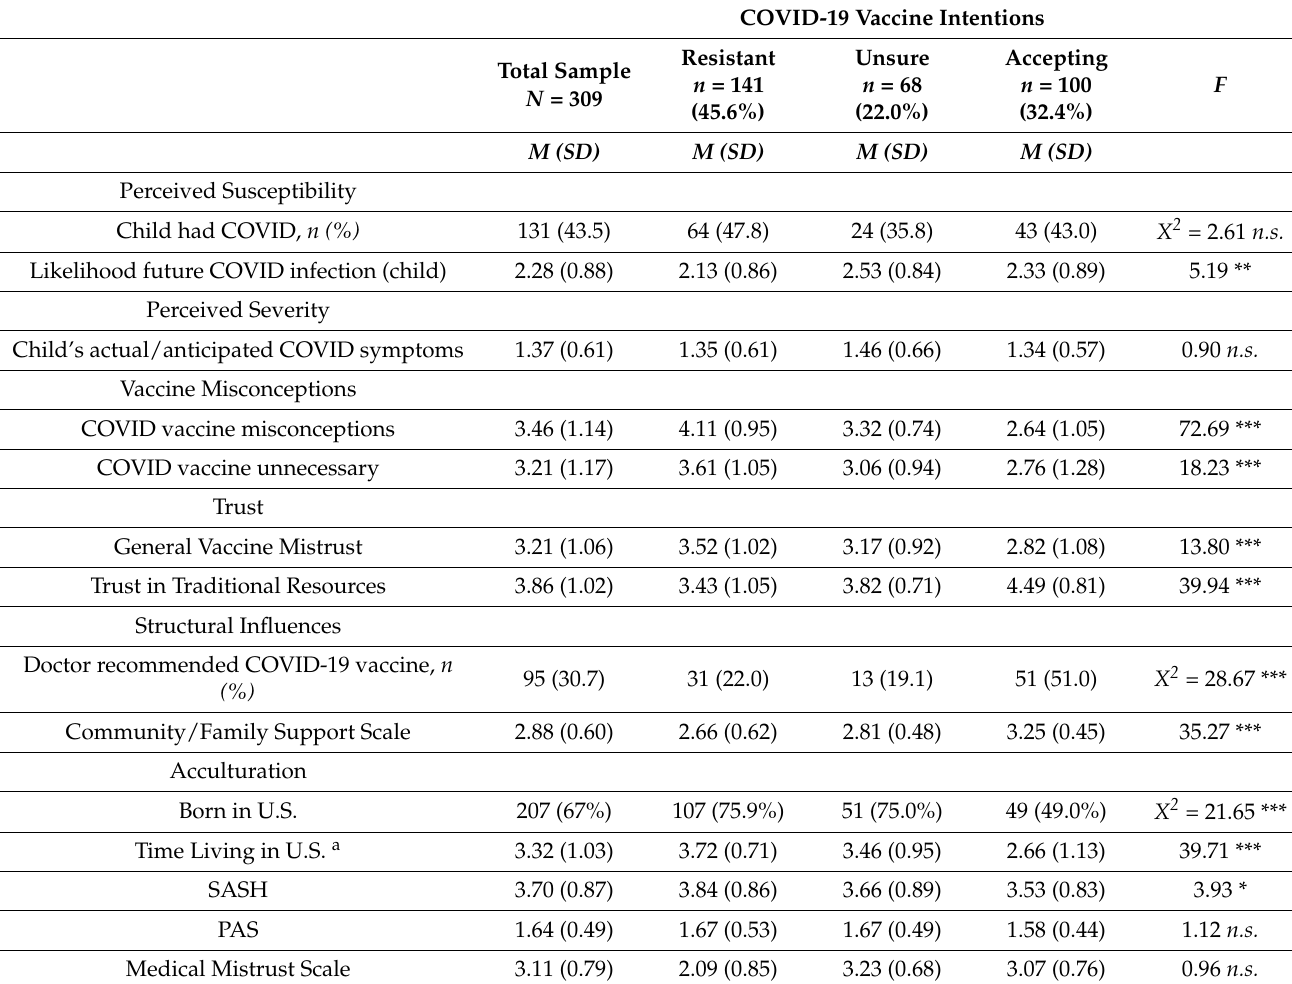
Table 2. Means/standard deviations and frequencies/percentages for social determinants and analyses of variance across COVID-19 vaccine intent